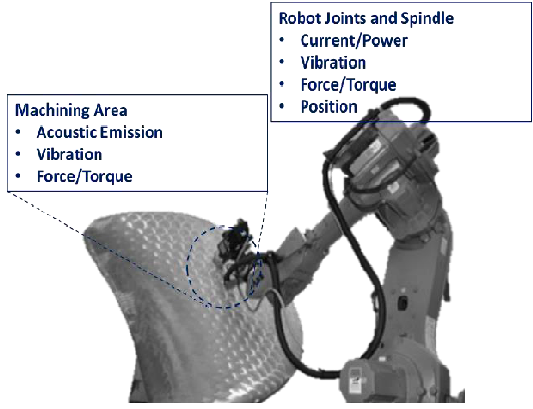
Figure 2. Measurable phenomena in machining environment.